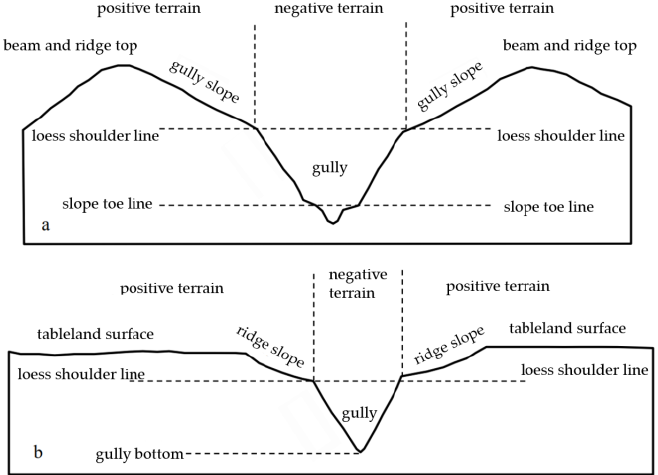
Figure 8. Schematic of the positive and negative topography of the Loess Plateau [55]. ( a ) loess hilly and gully area; ( b ) loess tableland area.